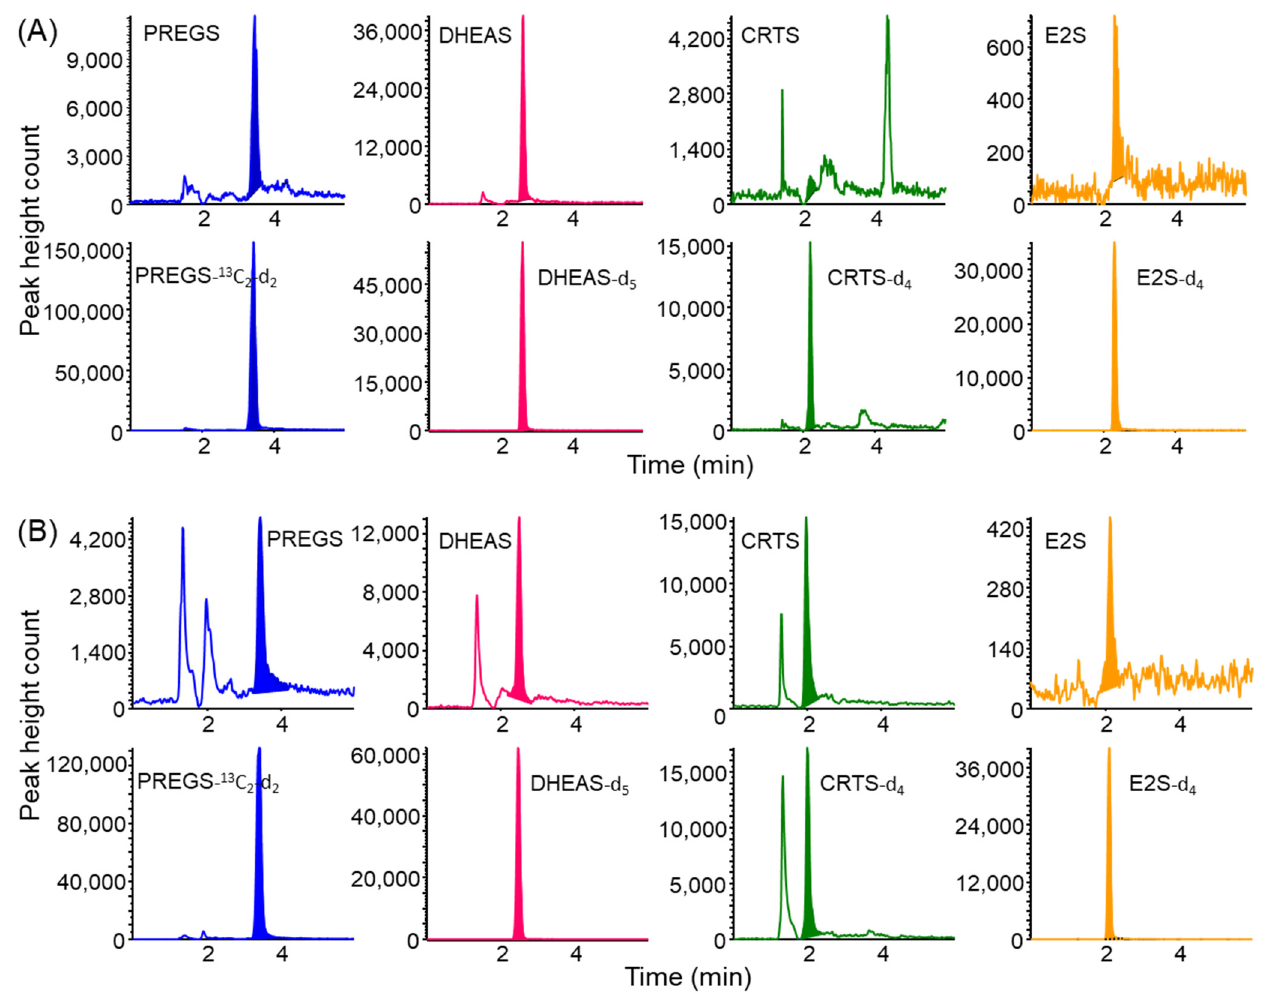
Figure 4. MRM chromatograms obtained from saliva samples of ( A ) a non-smoker and ( B ) a smoker by IT-SPME LC–MS/MS. Analytical conditions are described in Section 3.